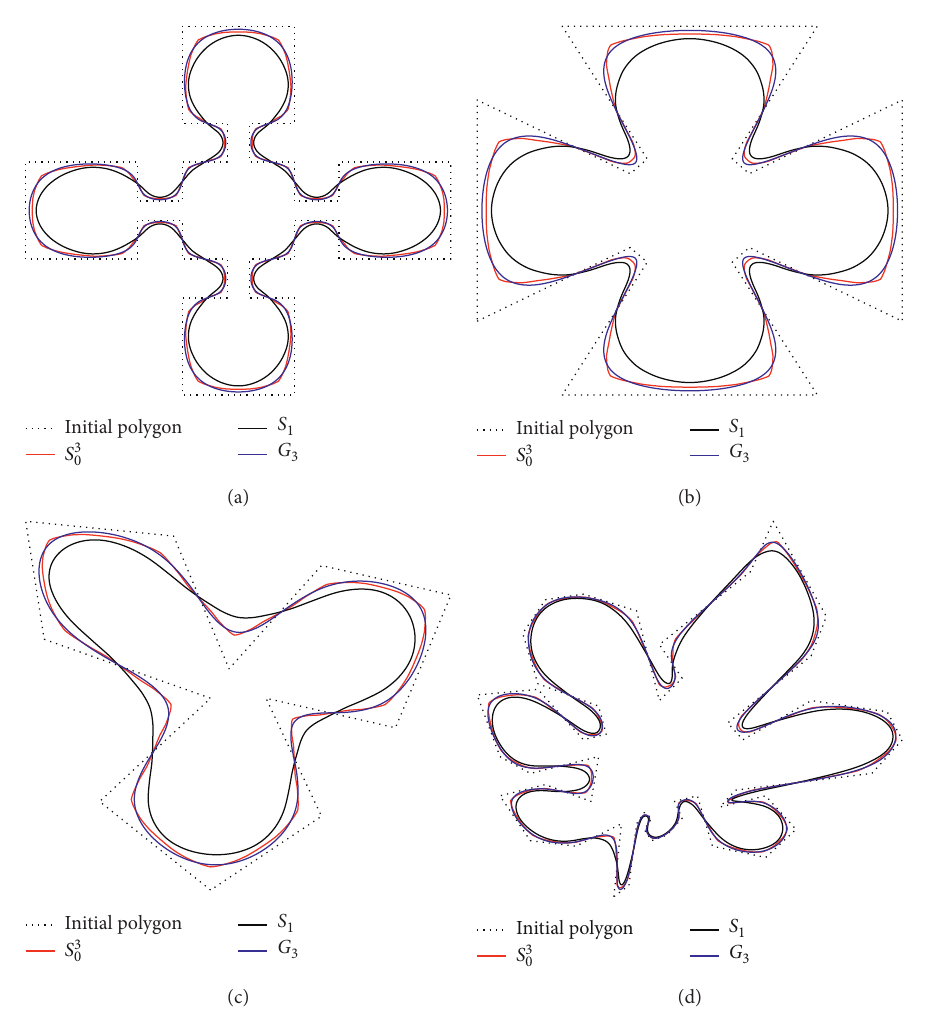
Figure 1: (a–d) Comparison of limit curves for close polygons produced by 3-point schemes S 3